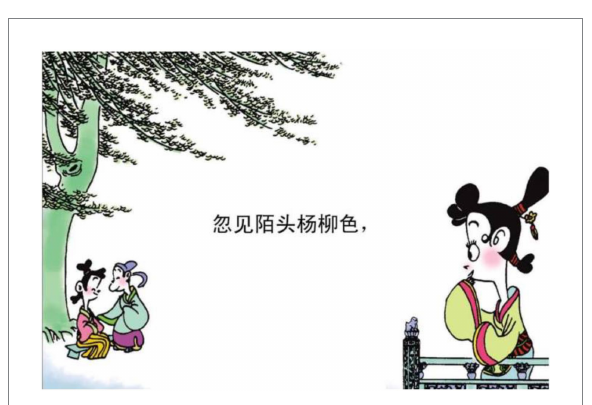
FIGURE 16 The forth panel on Cai (2014, p. 33). Images reproduced with permission from Shang Dong People Press.